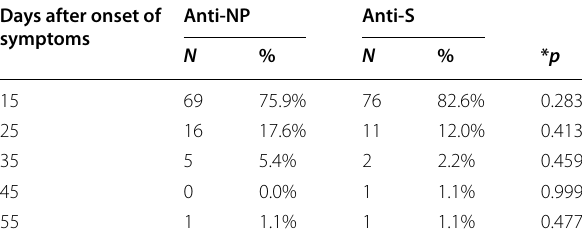
Table 2 Seroconversion of anti-NP and anti-S antibodies